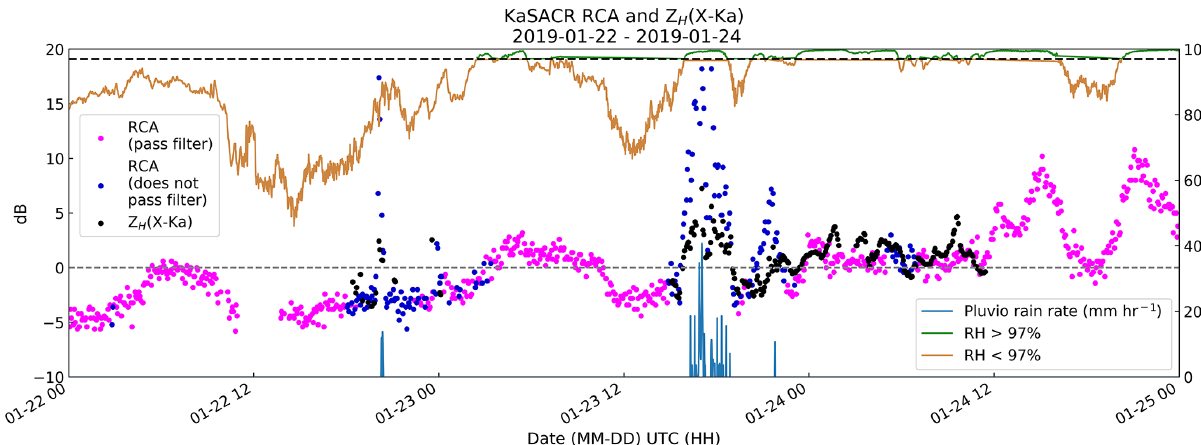
Figure 16. Sub-daily RCA for KaSACR at the COR site during a 72h period between 22 January 2018 and 25 January 2018. Sub-daily RCA is plotted by color, based on scan times that passed a relative humidity threshold of 97%. Rain rate from the Pluvio 2 rain gauge is shown to coincide with periods of high RCA values. Reflectivity cross comparison between XSACR and KaSACR is also plotted to compare and identify patterns suspected to be caused by changes in relative humidity or precipitation.